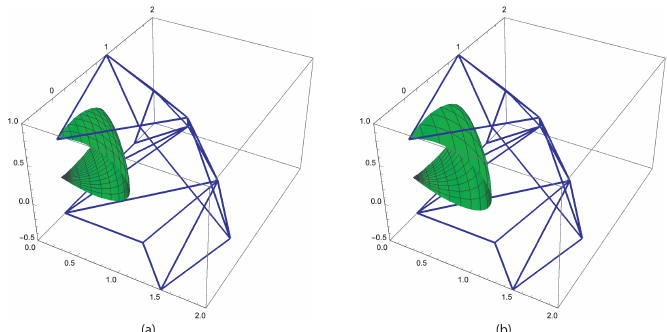
Figure 7: The truncated triangular Meyer-König-Zeller surfaces with ( m = 4, n = 1) (a) and ( m = 4, n = 3) (b).